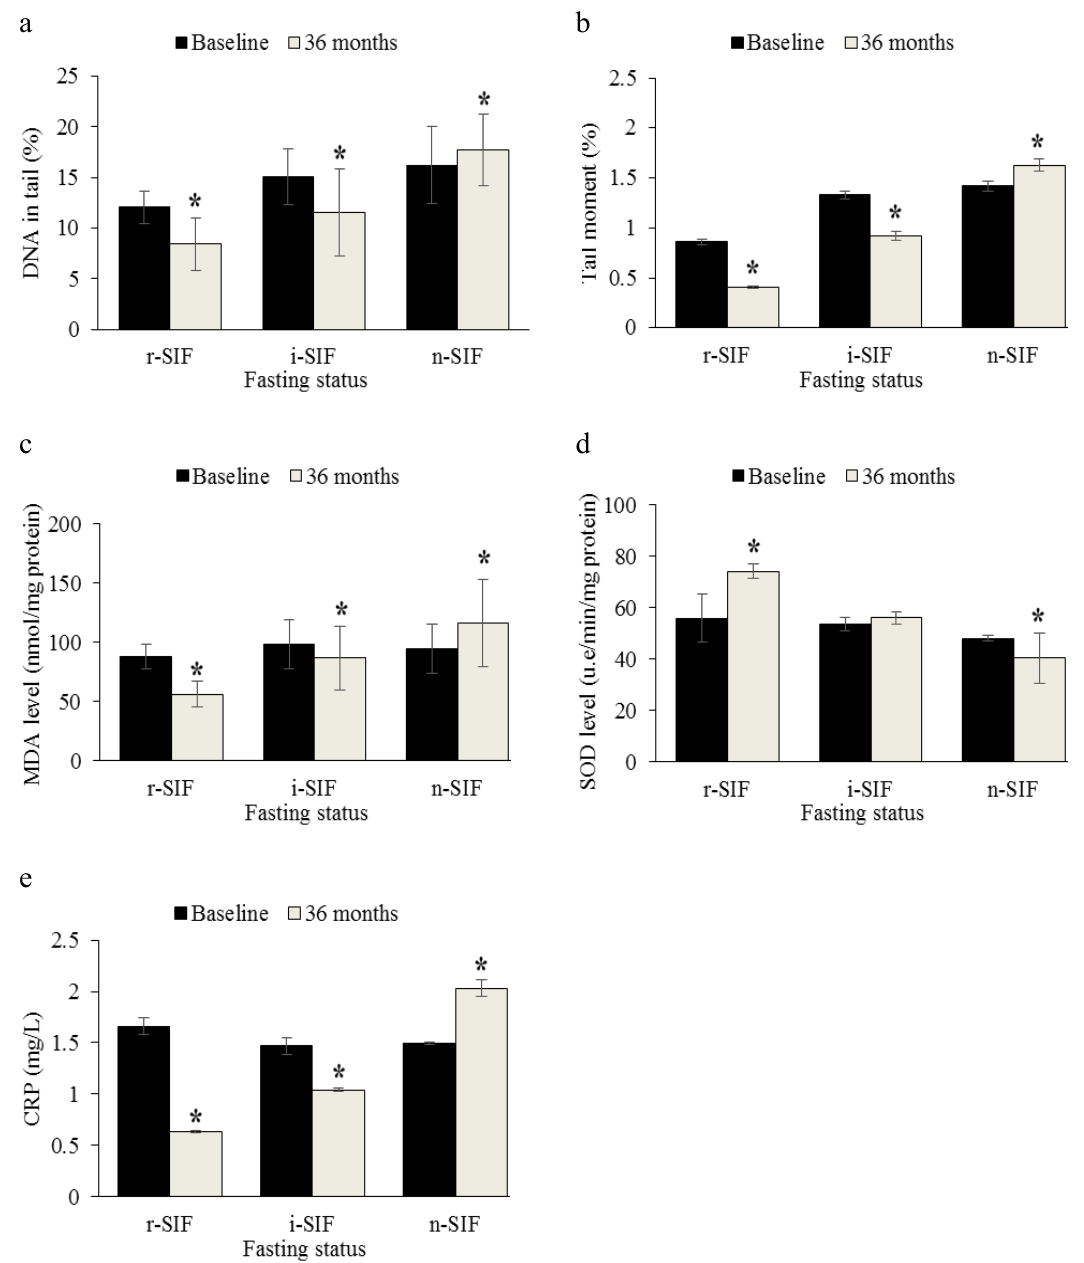
Figure 1. ( a ) Percentage of DNA in tail, ( b ) percentage of tail moment, ( c ) malondialdehyde (MDA) Figure 1. E ff ects of intermittent fasting (IF) on DNA damage, oxidative stress and inflammatory markers levels, ( d ) superoxide dismutase (SOD) activities, and ( e ) C-reactive protein (CRP) levels among in mild cognitive impairment-a ffl icted older adults. ( a ) Percentage of DNA in tail, ( b ) percentage three different IF groups across time. Repeated measures analysis of covariance (ANCOVA) between of tail moment, ( c ) malondialdehyde (MDA) levels, ( d ) superoxide dismutase (SOD) activities, group analyses with regard to time was applied. Numerical covariate (age, level of education) was and ( e ) C-reactive protein (CRP) levels among three di ff erent IF groups across time. Repeated measures controlled using repeated measures ANCOVA. * Significant difference as compared to baseline ( p < analysis of covariance (ANCOVA) between group analyses with regard to time was applied. Numerical 0.05). CRP: C-reactive protein; MDA: malondialdehyde; SOD: superoxide dismutase. covariate (age, level of education) was controlled using repeated measures ANCOVA. * Significant di ff erence as compared to baseline ( p < 0.05). CRP: C-reactive protein; MDA: malondialdehyde; SOD: superoxide